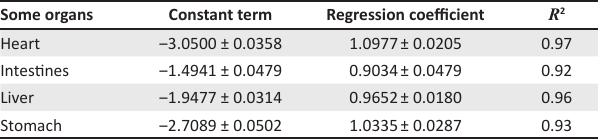
TABLE 5: Allometric coefficients relating the natural logarithm of the organ weights (kg) to the natural logarithm of empty body protein weight (kg) with dietary energy levels as groups to determine the effect on component growth (kg).